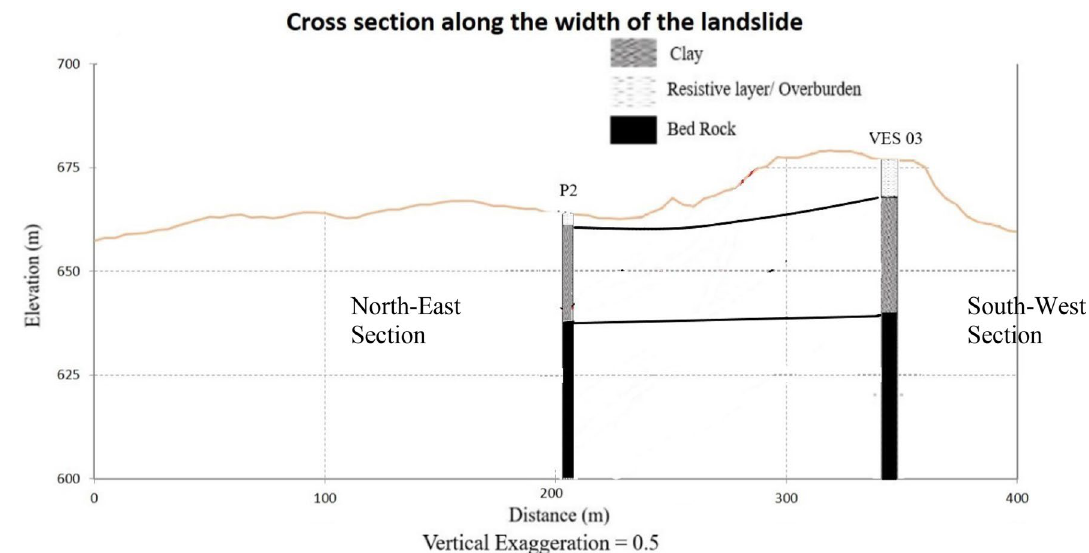
Fig. 9 Cross section of the subsurface across the width of the landslide between P2 and VES